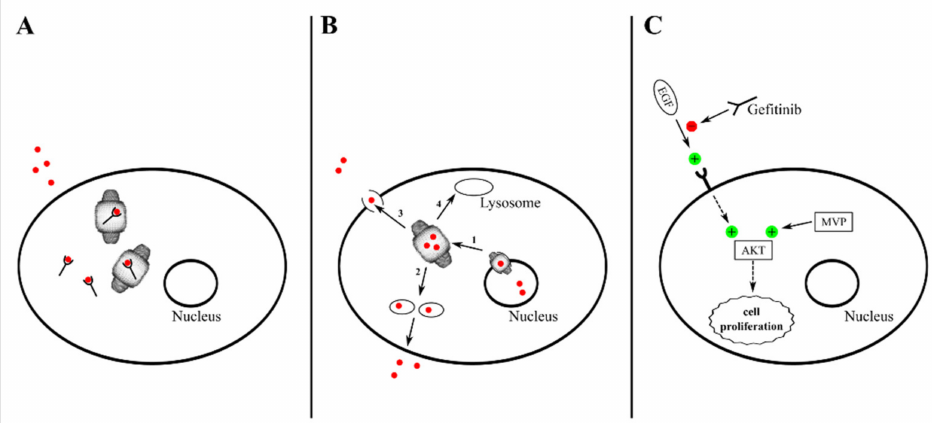
Figure 2. Mechanisms of vault-sustained drug resistance. ( A ) Some DNA-damaging drugs may be sequestered by vault- associated RNA molecules (vtRNAs). ( B ) DNA-damaging drugs may also: (1) be exported from the nucleus; (2), accumulate in cytoplasmic vesicles and undergo exocytosis; (3) be handed over to drug efflux pumps; (4) be sequestered in lysosomes. ( C ) MVP uncouples, by an unknown mechanism, protein kinase c (AKT) activation from EGF receptor (EGFR) stimulation, thus thwarting the inhibitory effect of gefitinib on the EGF/AKT signaling